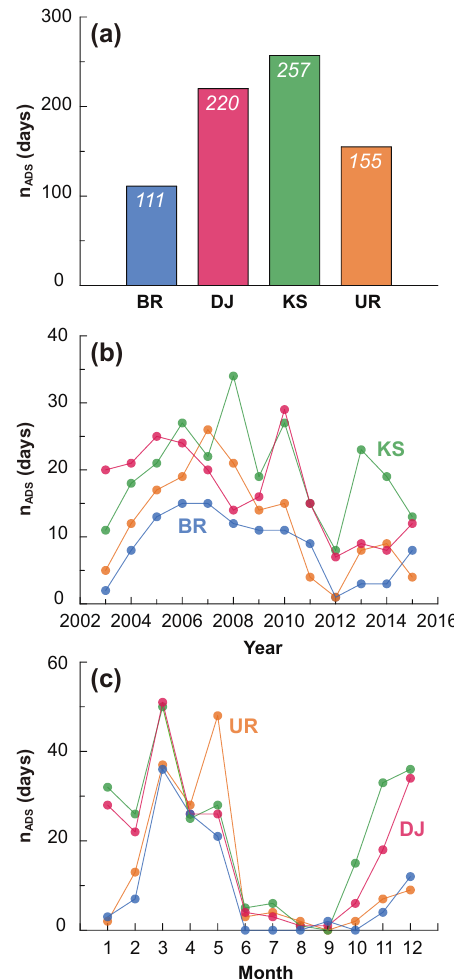
Figure 3. Comparison of ADS events for the past 13 years. (a) Number of days each year with ADS events ( n ADS ) in a his- togram, (b) annual variations of ADS events, (c) monthly variations of ADS